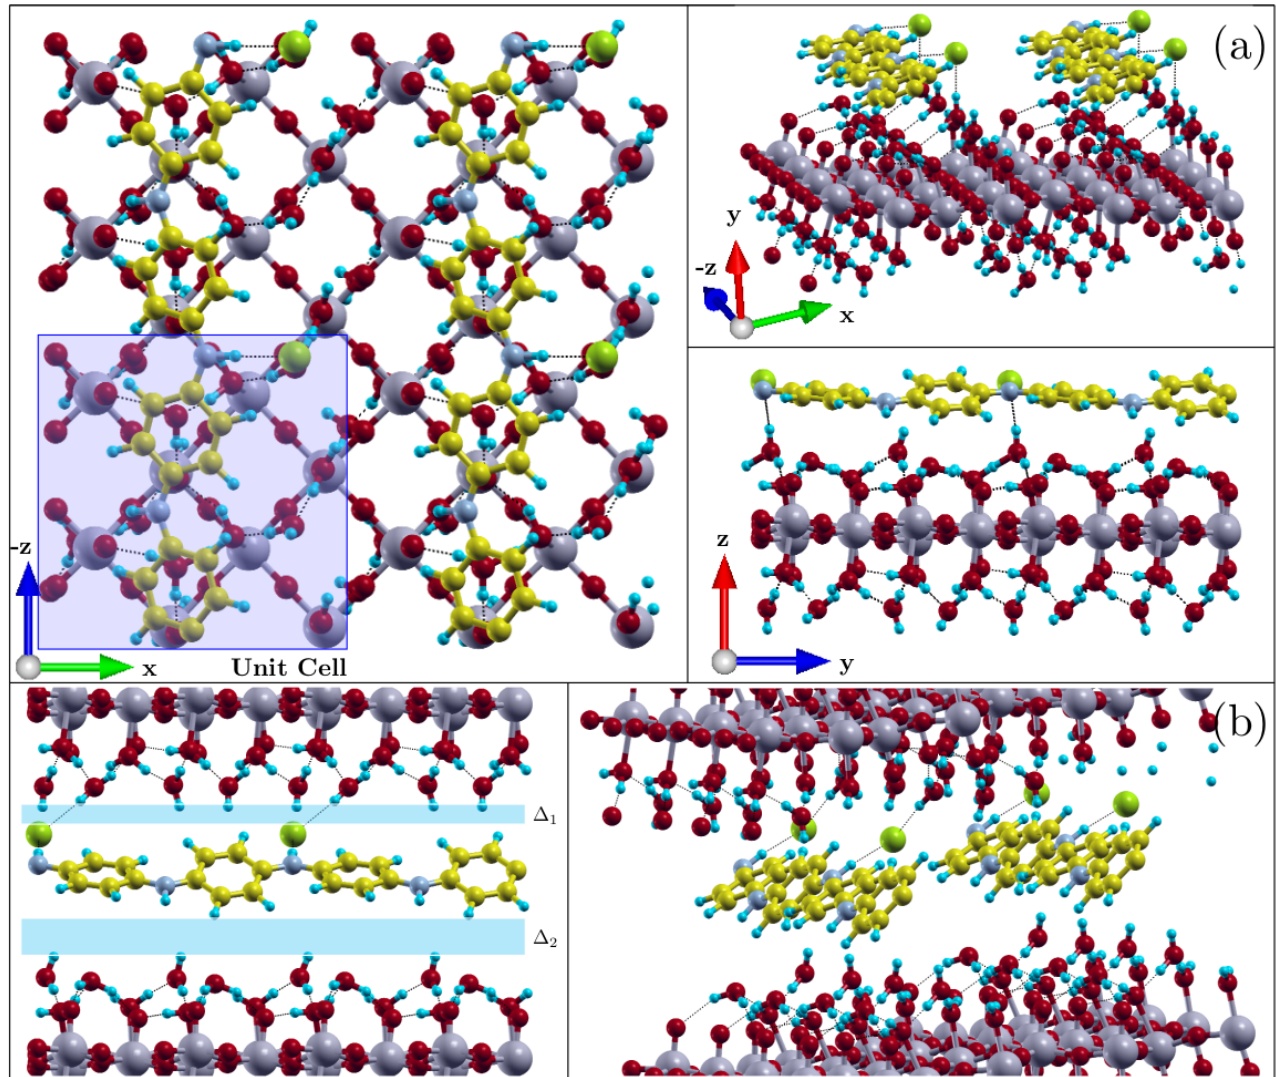
Figure 2. ( a ) Optimized structure of the periodically replicated PWO–ClS system (unit cell highlighted in blue). The polymeric phase was deposited on a WO 3 ·2H 2 O layer and, after geometric optimization, presented a distance of 0.60 Å. No changes in their molecular structures were observed, only a rearrangement in their bond lengths. ( b ) Optimized structure of the periodically replicated PWO–ClB system. The polymer phase interacted with two layers of WO 3 ·2H 2 O, presenting distances of Δ 1 = 1.17 Å and Δ 2 = 1.78 Å between the upper and bottom layers, respectively. No changes in their molecular structures were observed, only a rearrangement in their bond lengths in addition to the interaction between counter ions, polymer layer, and upper oxide layer. The bond lengths (Table 1) of the nanocomposite phases were evaluated in all pro- posed systems. The bond lengths in polymer and oxide phases are shown in Figure 3a–d.